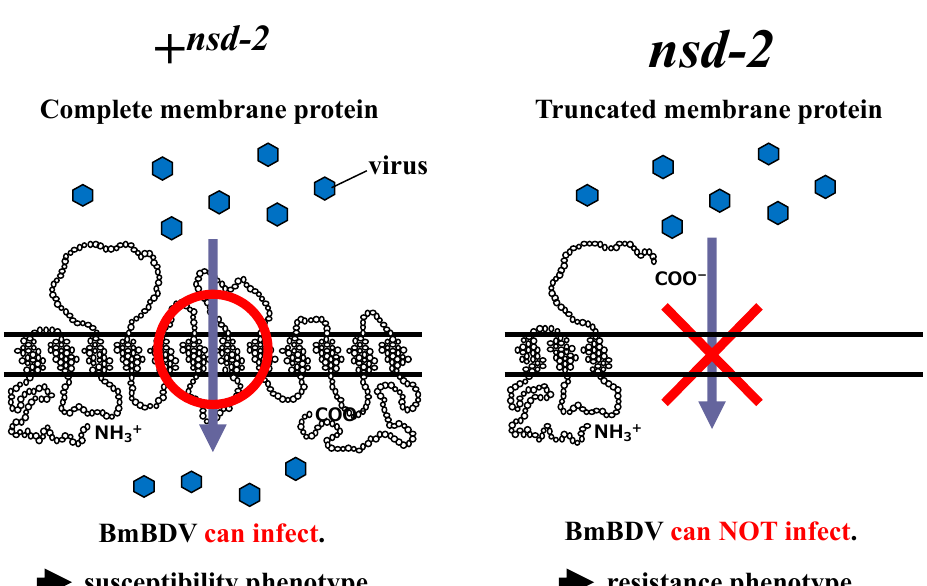
Figure 2. Relationship between BmBDV infectivity and virus susceptibility (+ nsd-2 )/ resistance ( nsd-2 ) gene products. The secondary structures of the NSD-2 protein derived from the + nsd-2 gene (left) and the nsd-2 gene (right) are based on the topology prediction method, SOSUI (http://harrier.nagahama-i-bio.ac.jp/sosui/ accessed on December 17, 2007).